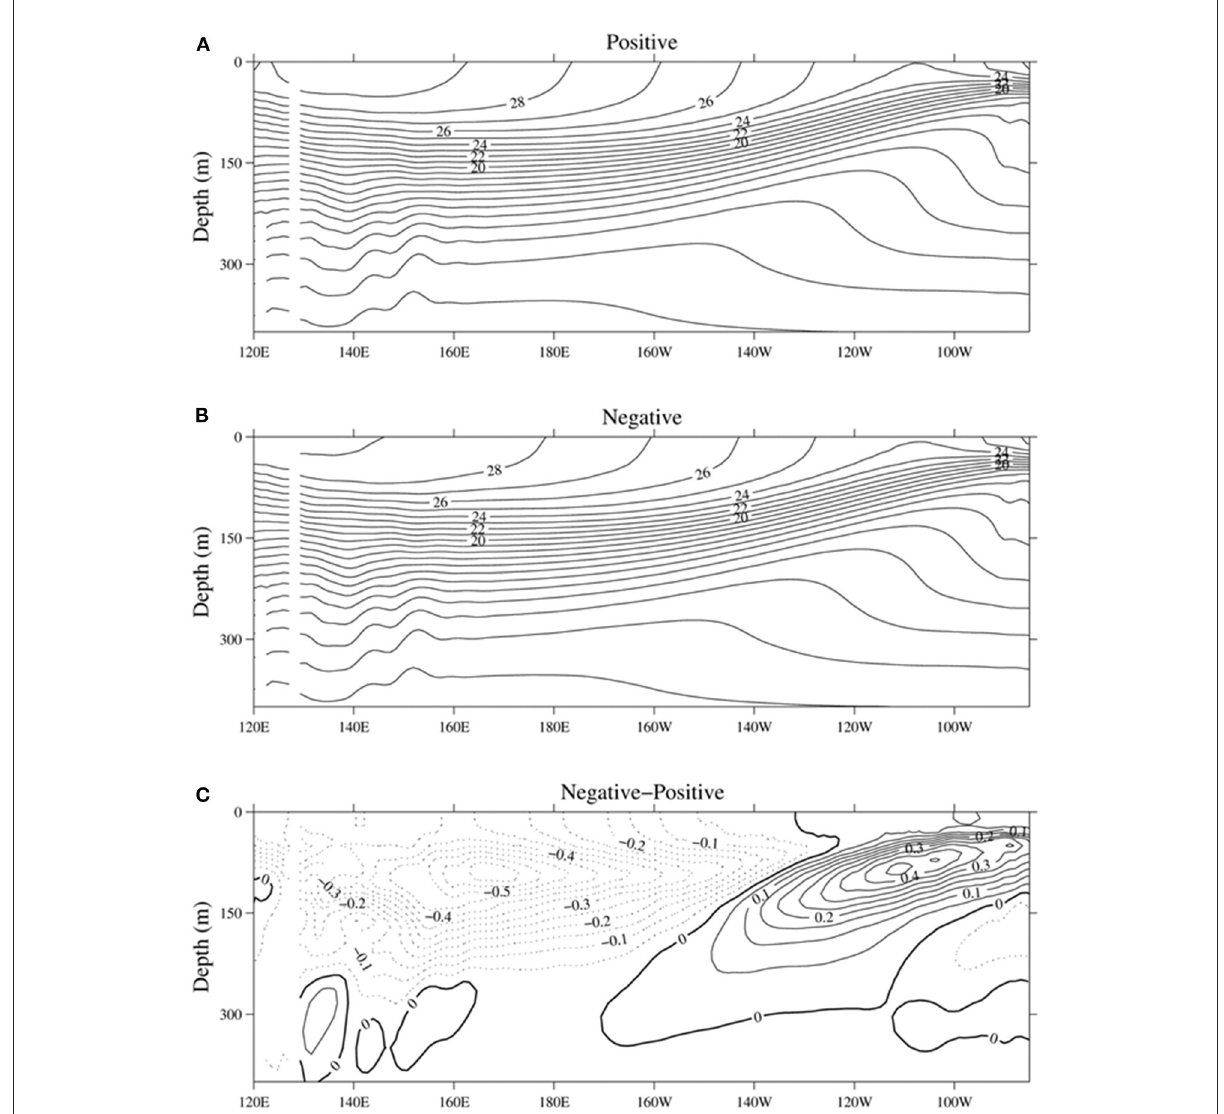
FIGURE13 Comparison of the mean vertical temperature distribution in the equatorial Pacific vertical section during the positive (A) and negative (B) phases of the decadal variability in the CCSM4 historical simulations. (C) Is the difference of (B,A) . Unit is ◦ C.